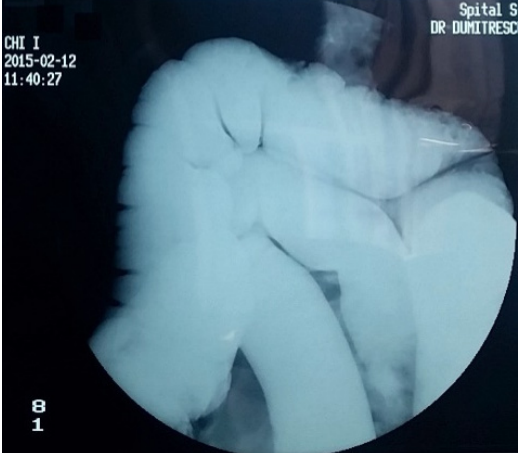
Figure 6. Significant reflux in the terminal ileum, which appears dilated, the consequence of transit disorders and fecal stasis in the colon.